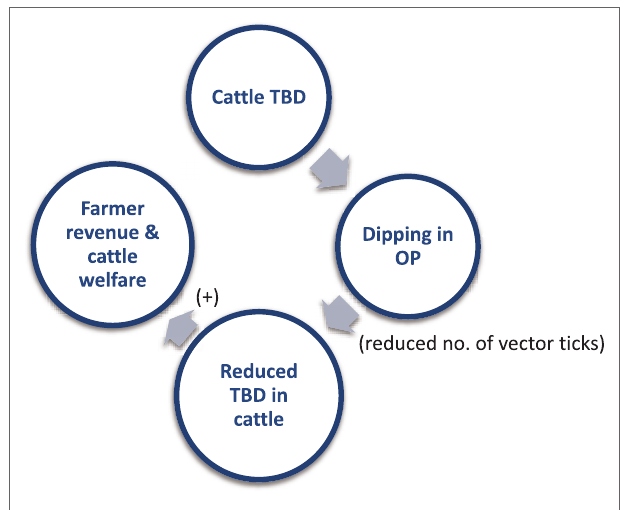
Figure 1 | Flow of operations relating to the Animal Health Programme